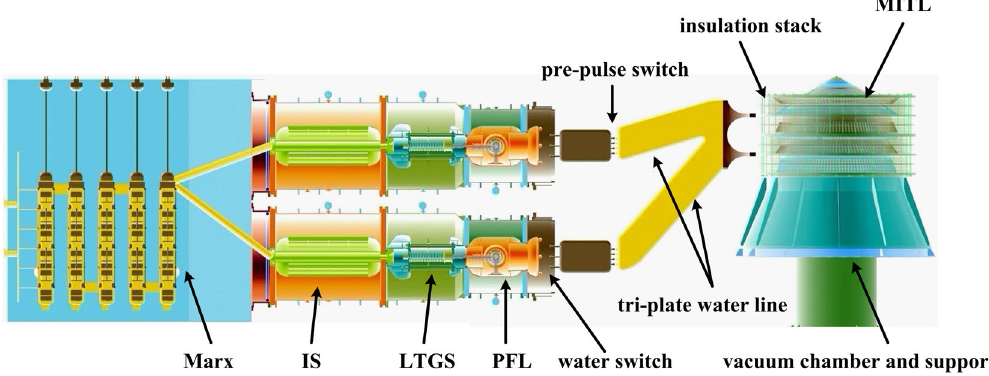
FIG. 2. Cutaway view of two modules in the PTS. The two Marx generators overlap with each other in this viewpoint. They are connected to the upper and lower module separately. The target position is higher than the insulator stack and transmission lines in the PTS to facilitate diagnostic arrangement. Thus, there is a difference of 30 ns between the vertical triplate water lines of the two modules.